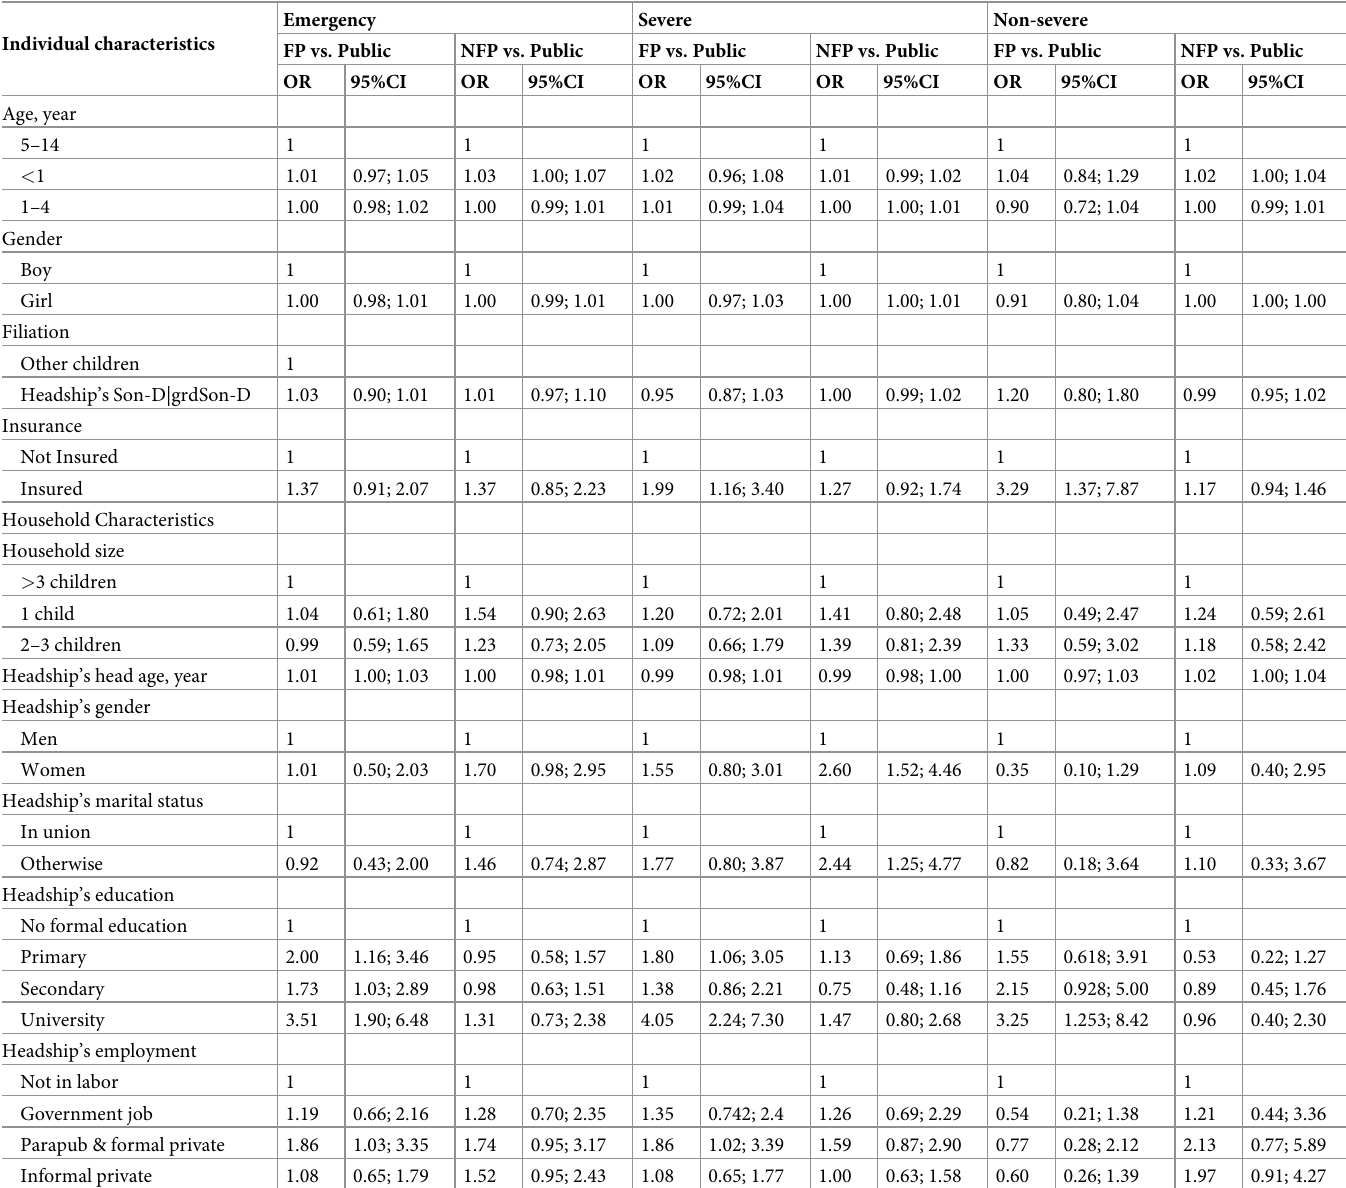
Table 5. Multivariate GEE of the choice between the formal providers by urban children by health